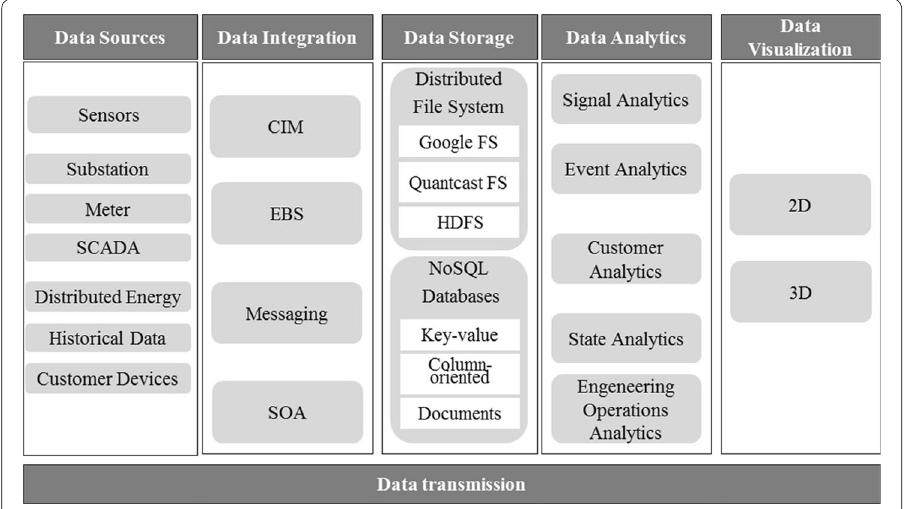
Fig. 5 Big Data architecture for smart grid. Big Data life cycle is composed by five phases: data sources, data integration, data storage, data analysis and data